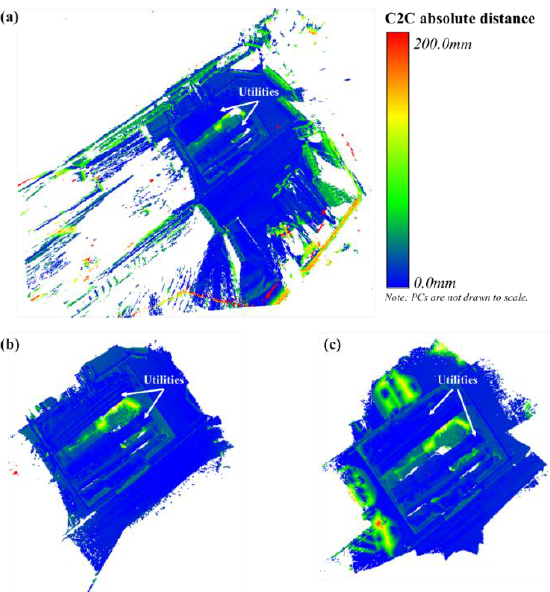
Figure 6 . C2C distance for (a) S20, (b) XT1092 and (c) D3200.